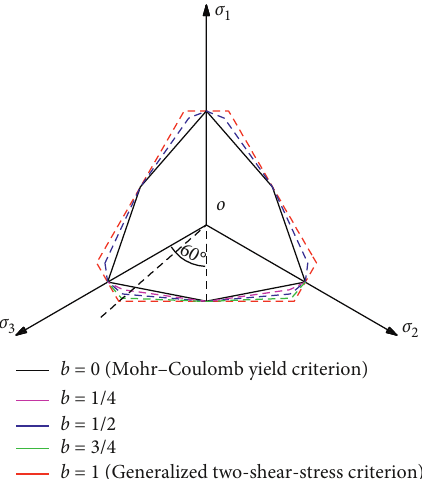
Figure 3: Unified strength theory yield curve in the π -plane [16].